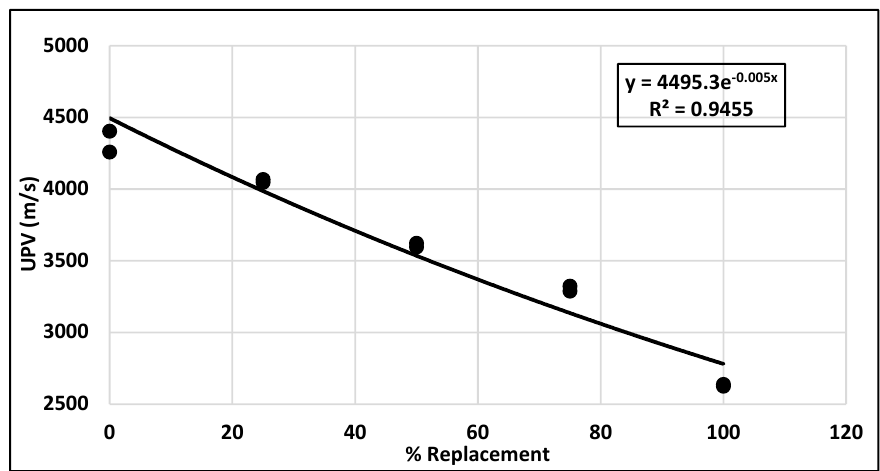
Figure 10. The statistical relationship between % replacement of carbon black and ultrasonic pulse velocity.